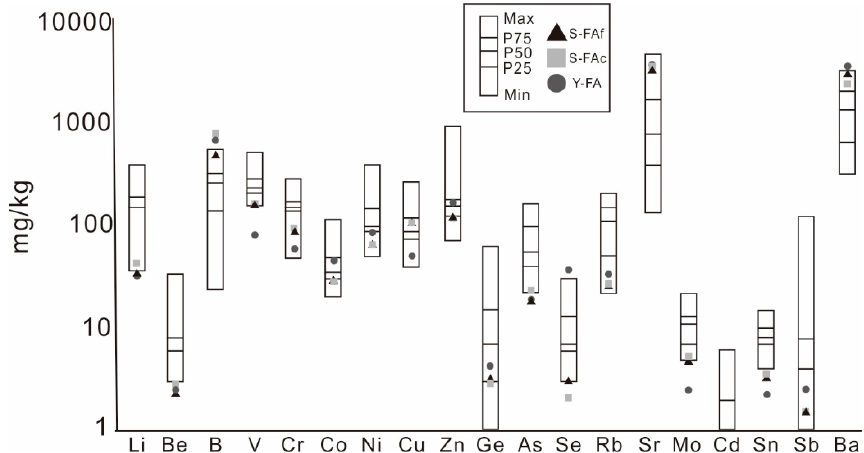
Figure 6. Concentrations of selected trace elements in the fly ashes at Shenhuo and Yihua power plants compared with the corresponding maximum, minimum, P25, P50, and P75 values in European fly ashes [52].